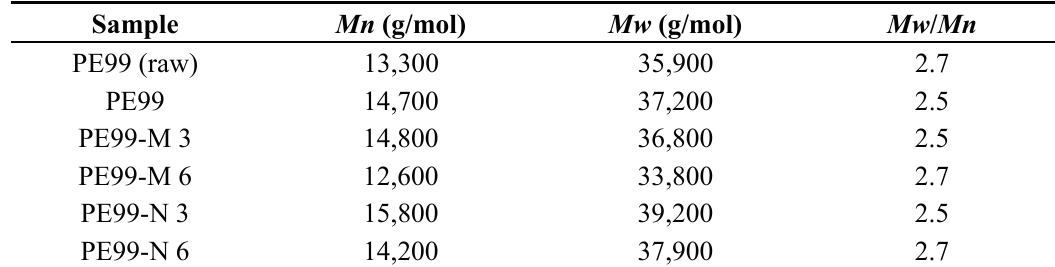
Table 1. Molecular weights of processed PE 99 and their mixtures with functionalized micro- and nanoparticles a .